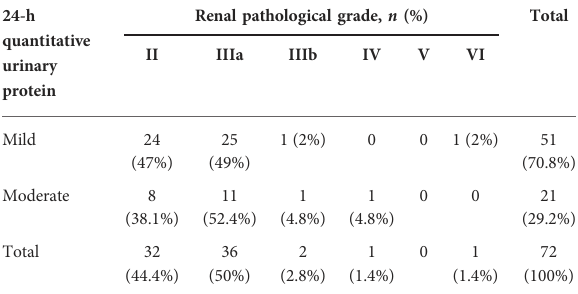
TABLE 4 Comparison of renal pathological grades between the mild proteinuria and moderate proteinuria groups.